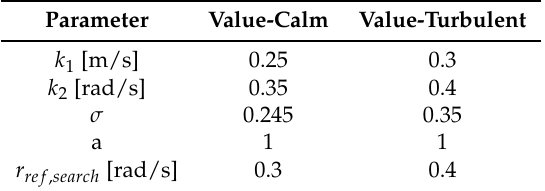
Table 1. Regulator parameters.